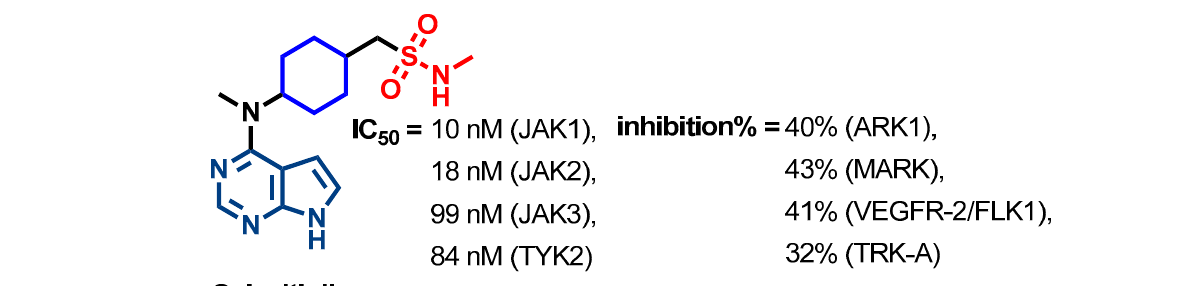
Figure 38. JAKs inhibitory activity of oclacitinib. Figure 38. Kinase inhibitory activity of